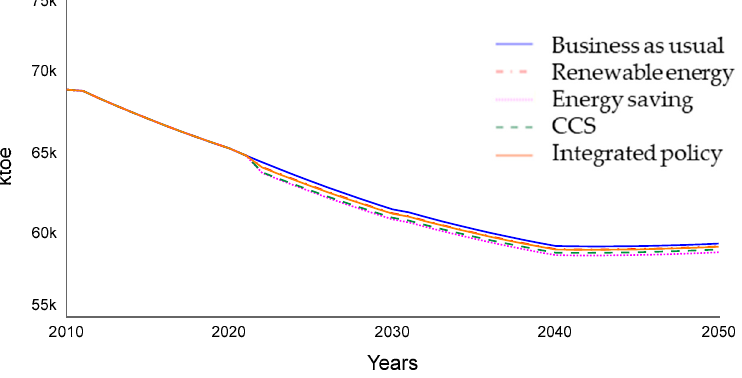
Figure 7. Total primary energy demand per year 2010 – 2050.